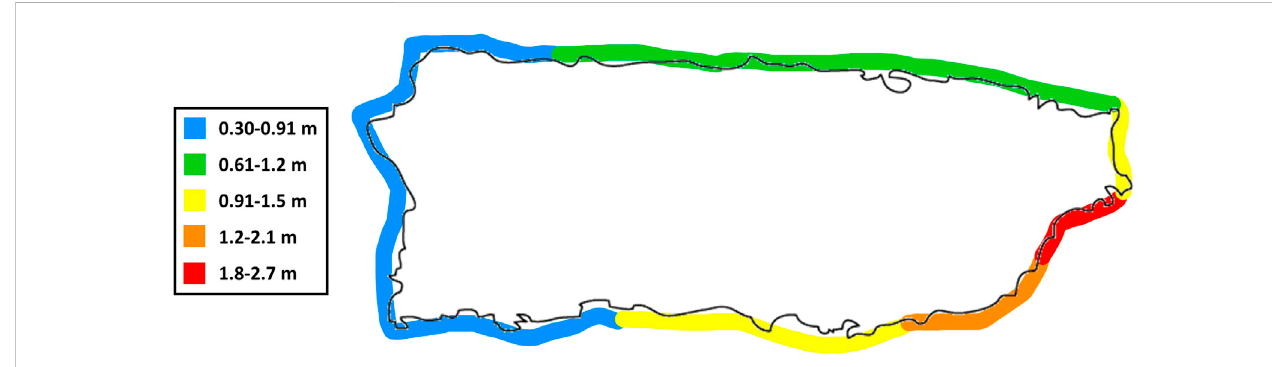
FIGURE 2 Estimated storm surge inundation along the coasts of Puerto Rico adapted from Pasch et al. (2017).